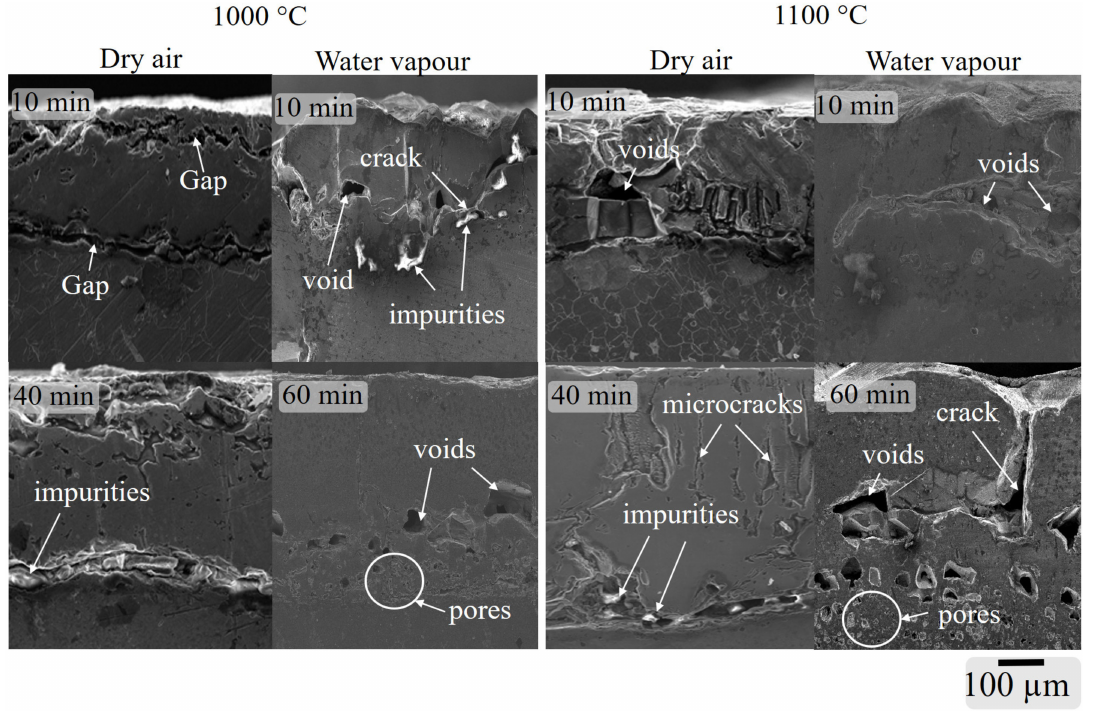
Figure 8. SEM micrographs of oxide scales formed under dry air and water vapor conditions on an HSLA steel oxidized at 1000 and 1100 ◦ C at di ff erent holding times.